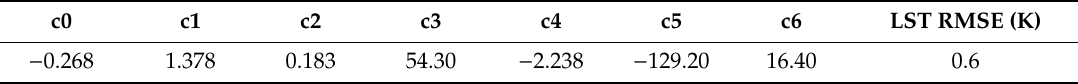
Table 2. Coe ffi cients for the split-window algorithm and the land surface temperature (LST) RMSE from the linear regression by Jim é nez-Muñoz et al. [12]. c0 c1 c2 c3